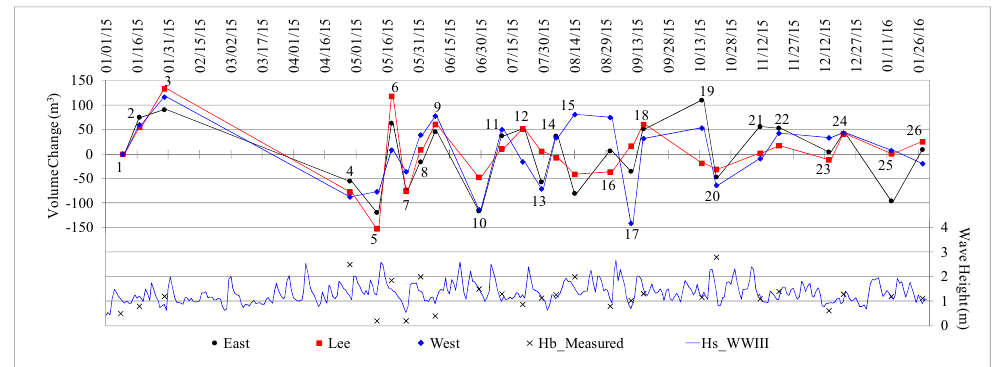
Figure 4. Beach mobility in sediment volume changes at the east, west, and lee of the Reserva rocky bank. The numbers represent each case presented in the deposition, erosion, and dissipative groups. Significant wave breaking height (Hb_Measured) data were measured at Reserva Beach. The continuous series of significant wave height (Hs_WWIII) was obtained using the wave generator model WAVEWATCHIII ® .